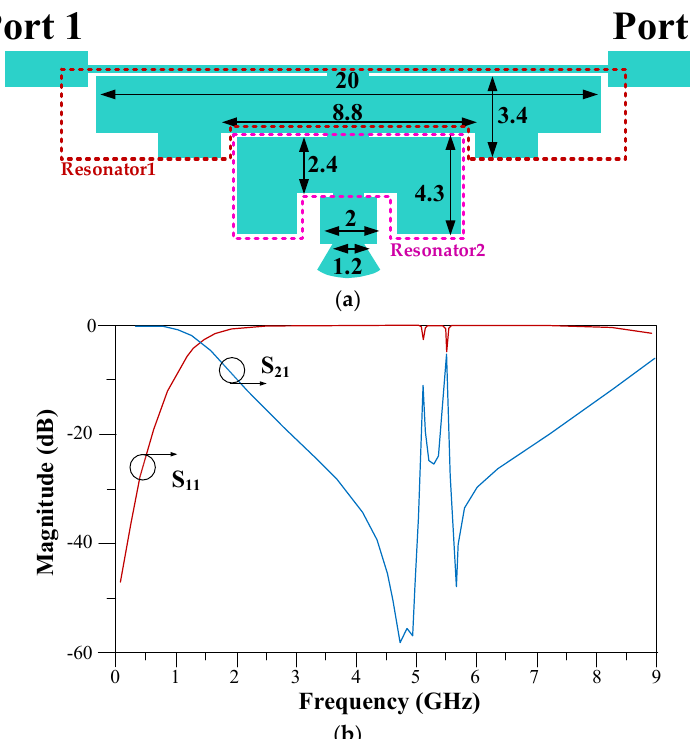
Figure 8. Final horizontal resonator: ( a ) layout and ( b ) frequency response. All dimensions are in the millimeter unit.